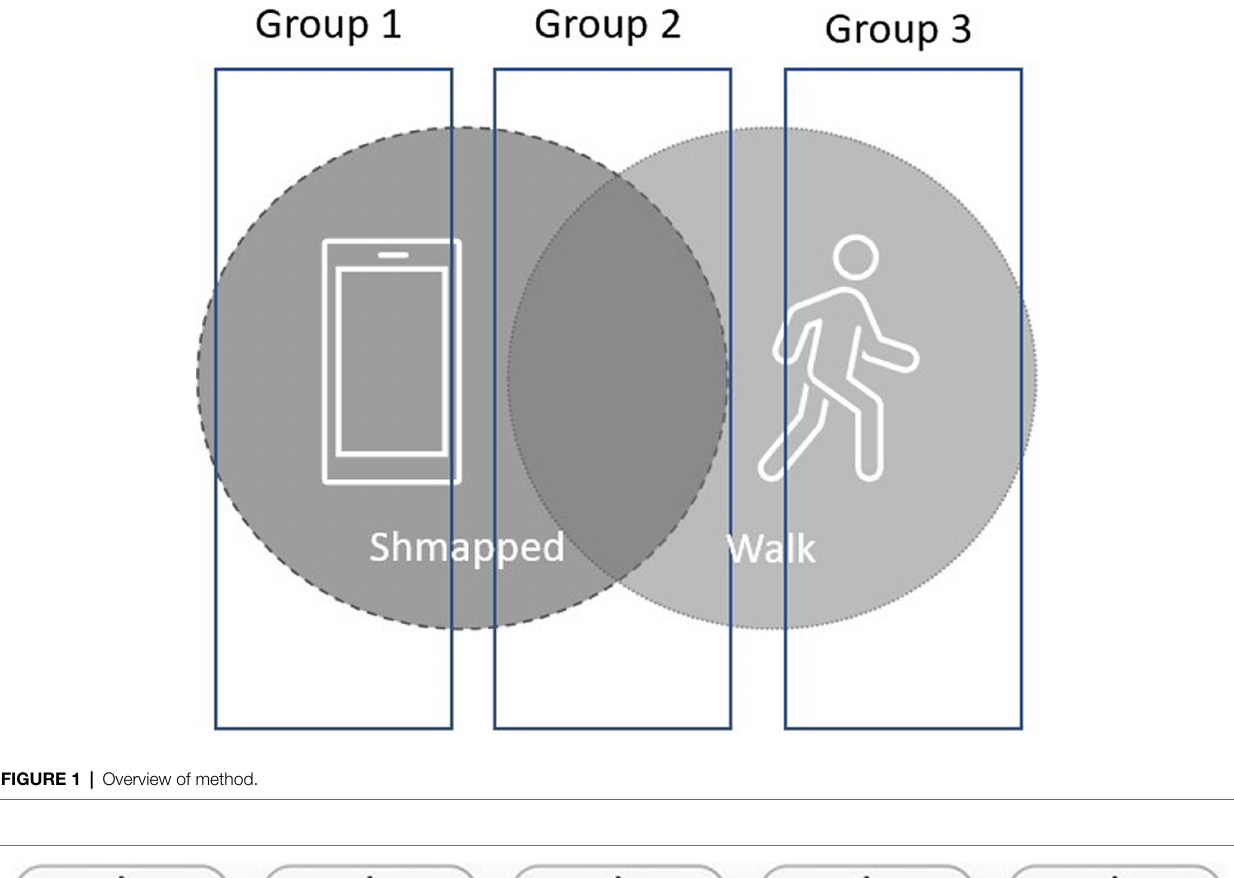
FIGURE 1 | Overview of method.